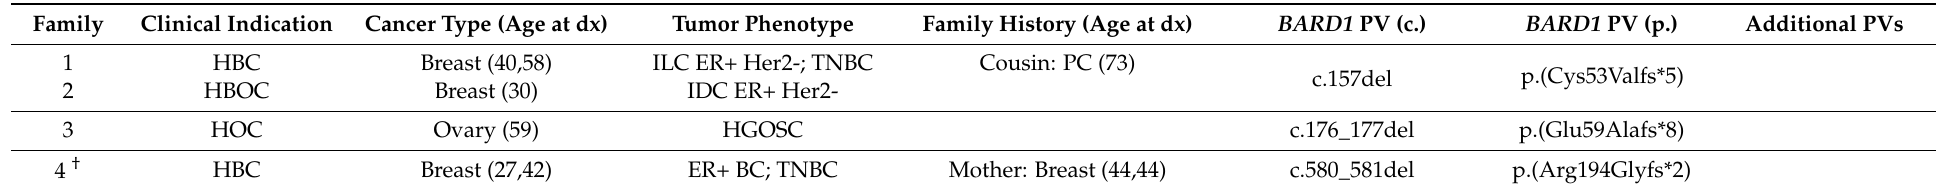
Table 2. Genotype and phenotype data of index patients carrying heterozygous germline pathogenic variants in the BRCA1-associated ring domain 1 ( BARD1)